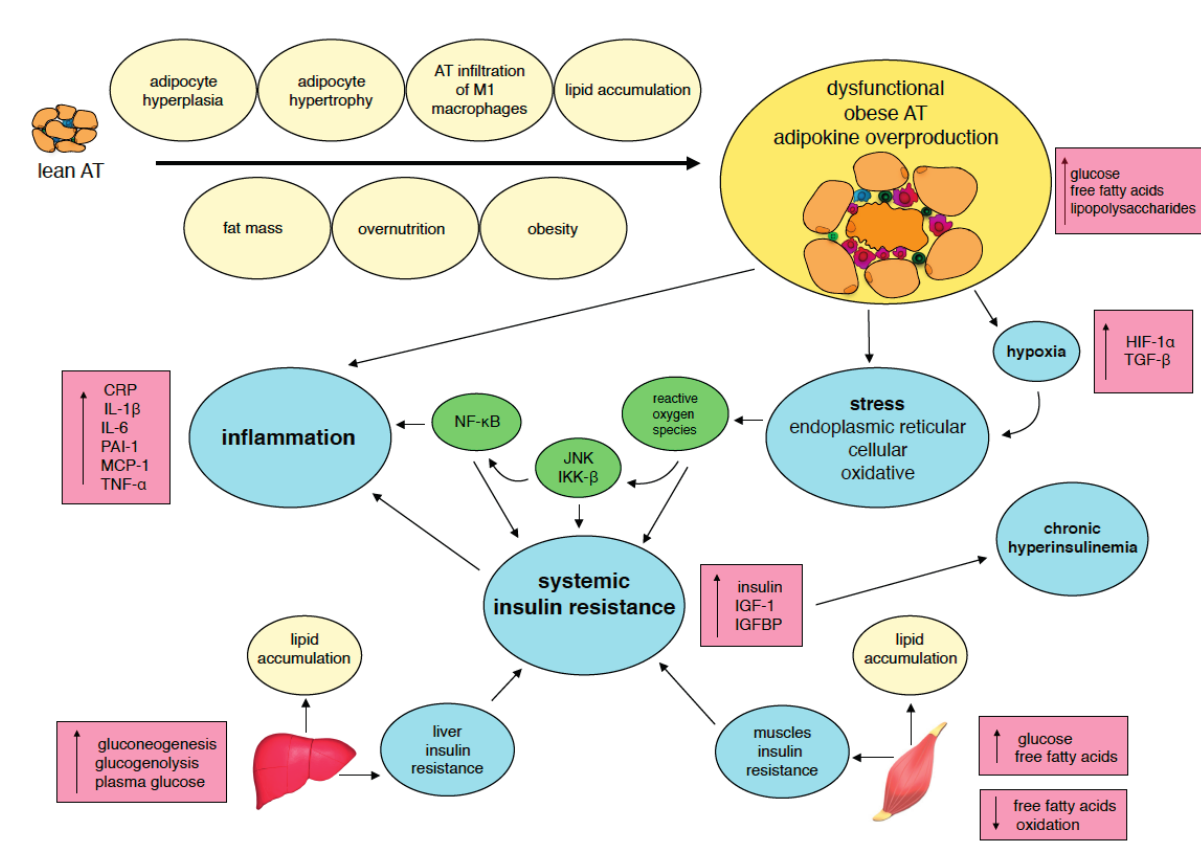
Fig. 2. Relationships among inflammation, insulin resistance (IR), and stress in adipose